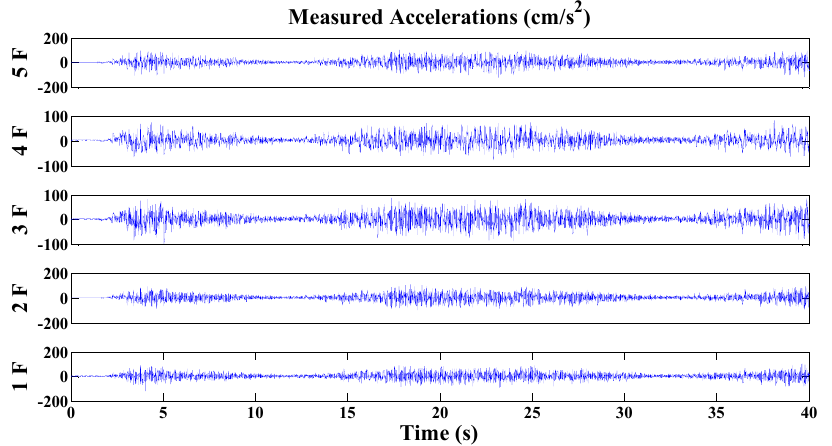
Figure 22. Acceleration time histories of the large-scale framework model excited by a shaking table.